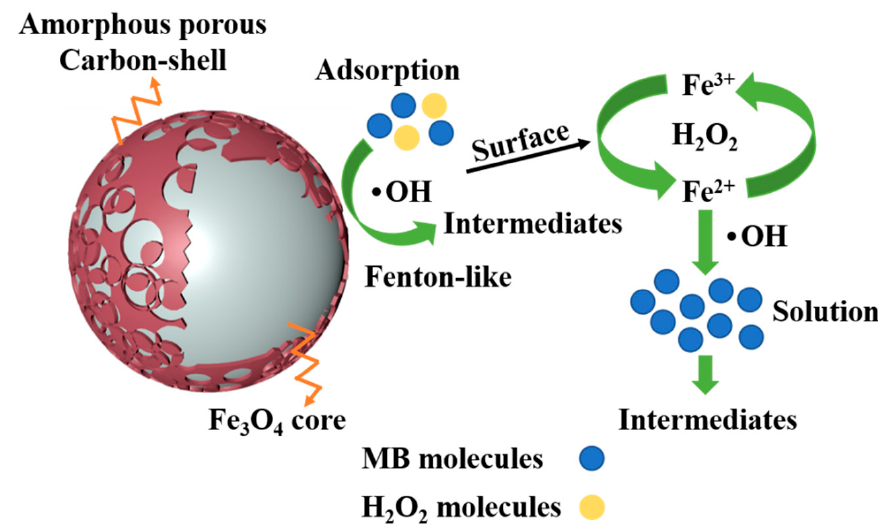
Figure 9. The activation mechanism of H 2 O 2 on Fe 3 O 4 @C nanoparticles.